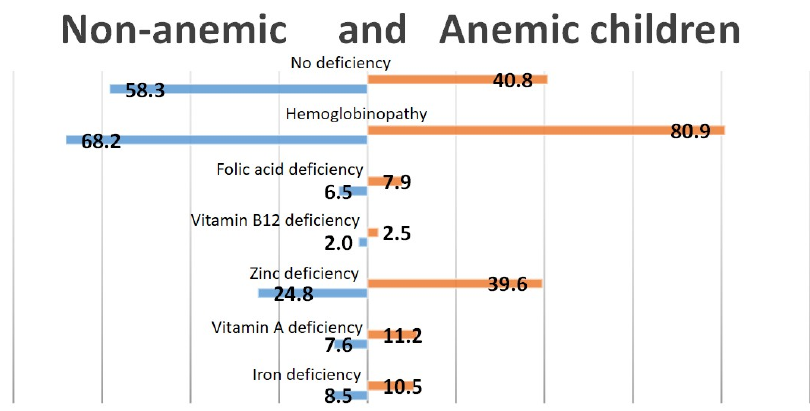
Figure 1. Prevalence of nutritional deficiencies and hemoglobinopathy in anemic and non ‐ anemic